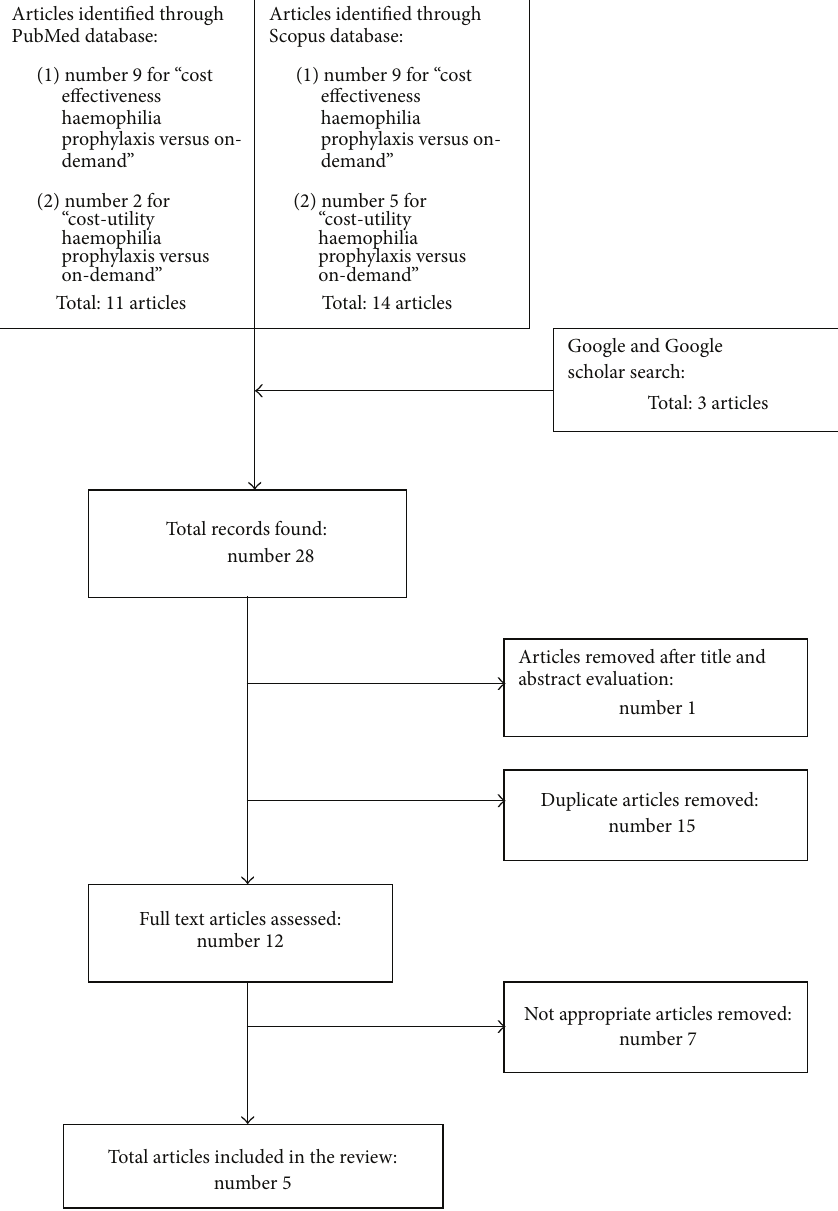
Figure 1: Flow chart of the selection